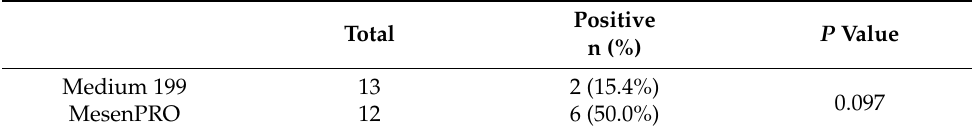
Table 2. Number of samples with TRAP + cell induction.